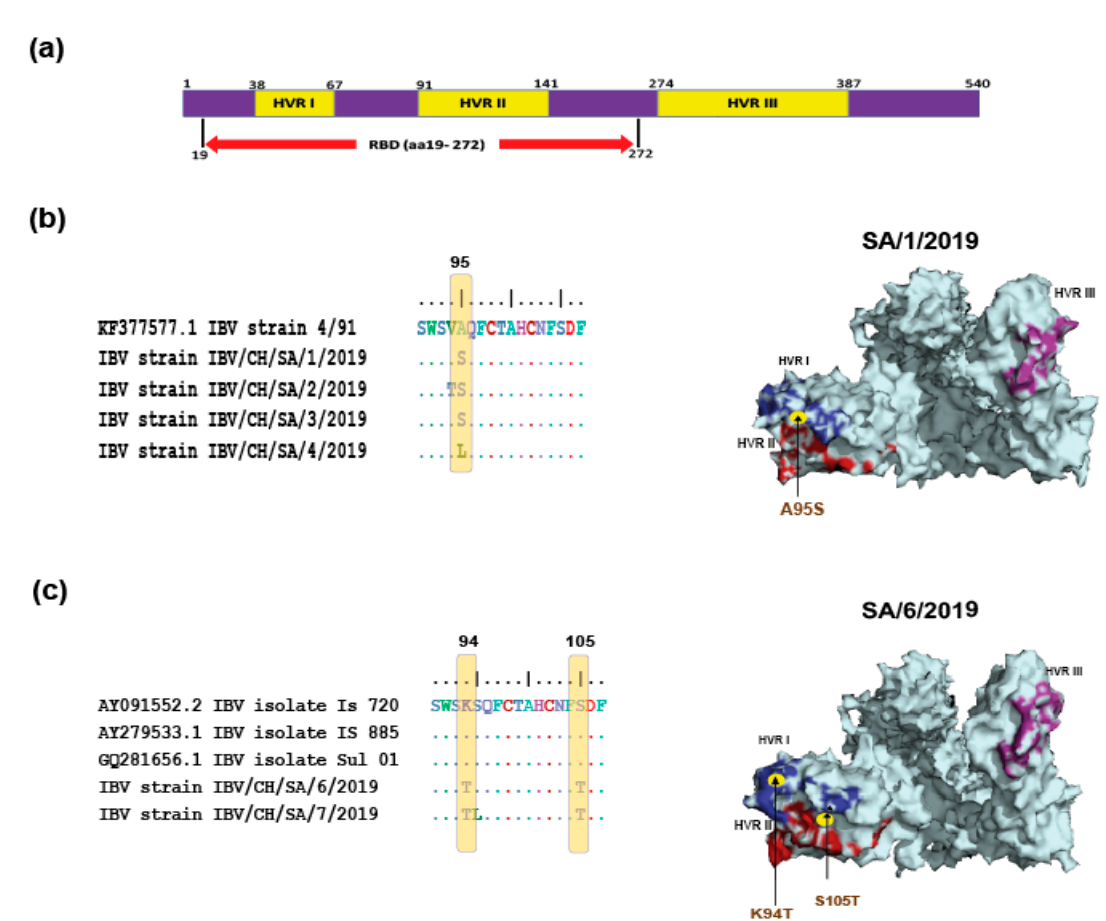
Figure 3. Characterization and localization of specific mutations in the spike protein of the newly identified IBV strains in comparison with their parental origin (GI-1, GI-13, and GI-23 lineages). ( a ) Schematic diagram based on the identified functional domains of S1 protein. ( b ) The multi-alignment of S1 glycoprotein, conducted by BioEdit, showed the location of specific mutation sites within the receptor-binding domain (RBD). Briefly, 3D structure template was downloaded from PDB database, and the hypervariable regions (HVR) regions of IBVs SA/1/2019 ( b ) and SA/6/2019 ( c ) isolates compared to their parental origin 4/91 (793b) genotype and IS/720/99 genotypes, respectively, were predicted. The 3D structure was visualized by PyMOL software.